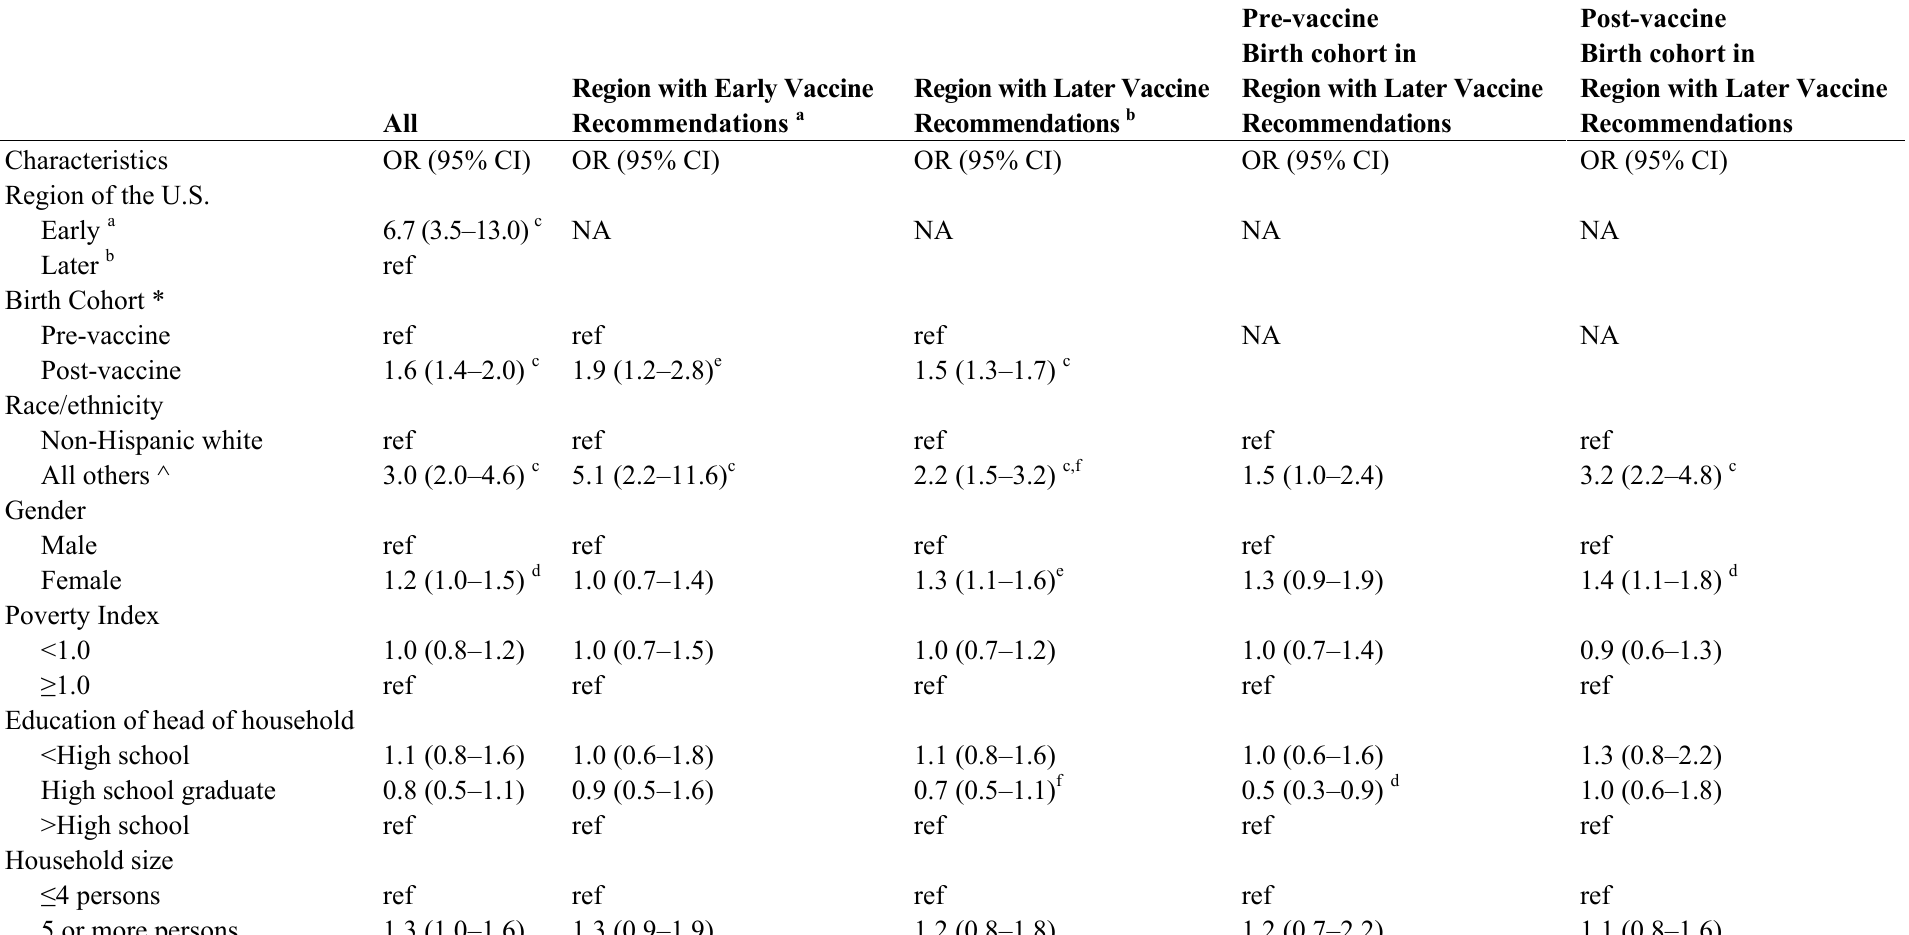
Table 2. Predictors of HAV seropositivity from logistic regression models among U.S. born children and adolescents 6–19 years of age by region based on HAV vaccine recommendations and birth cohort: NHANES